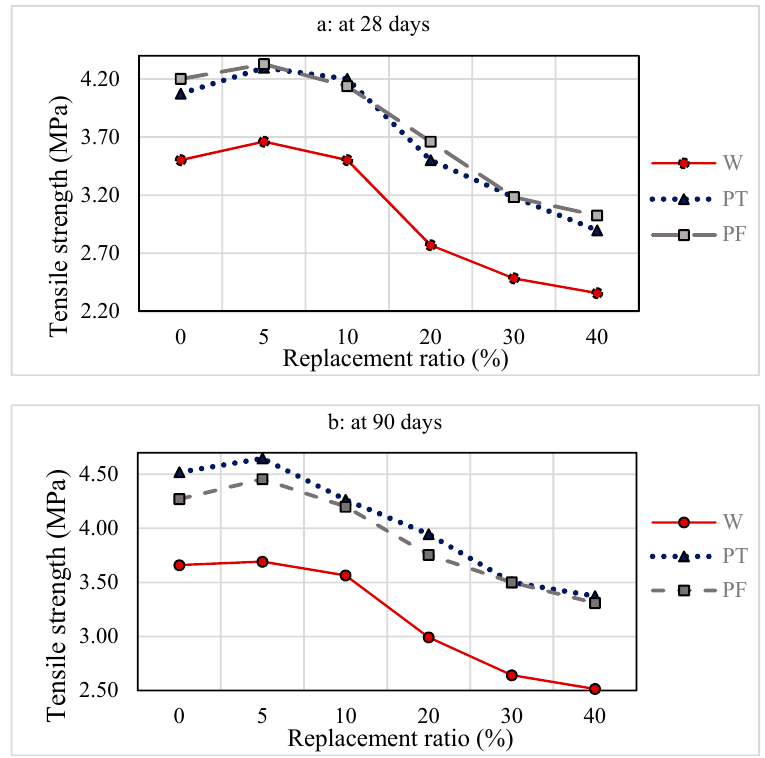
Figure 12. f ctm at various replacement ratios.